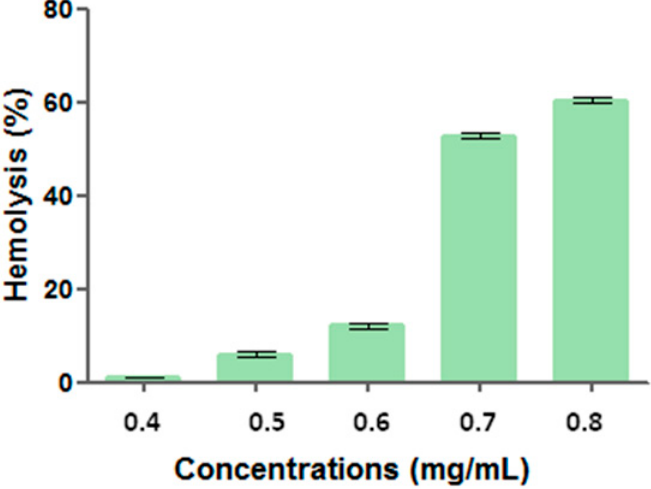
Figure 3. Hemolytic activity (%) versus surfactant solution concentration.